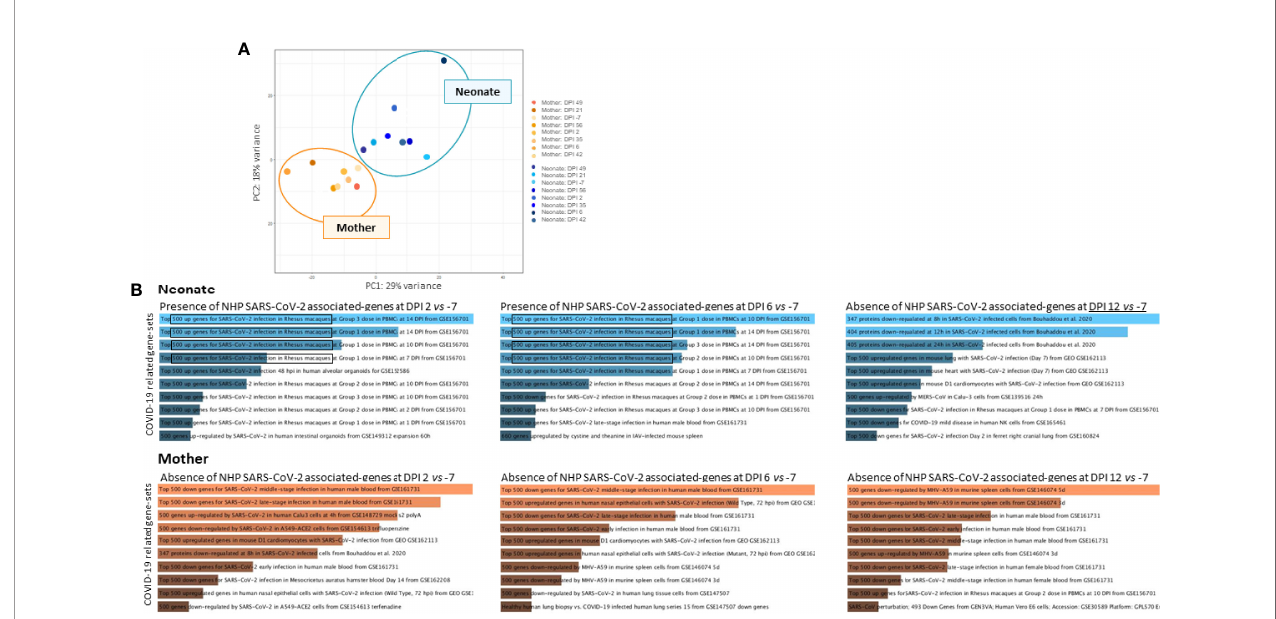
FIGURE 3 | RNA-sequencing analyses of whole blood. RNA-sequencing experiments on longitudinal whole blood samples (DPI − 7, 2, 6, 12, 21, 35, 42, 49, and 56) to detect the presence of COVID-19-associated gene sets. (A) Principal component analysis (PCA) of neonate samples (blue) and mother samples (orange) show no association between individuals where mother and neonate samples are presented. (B) Increased host-responding genes to SARS-CoV-2 infection at DPI 2 and DPI 6 compared with the baseline at DPI − 7 were observed, in the neonate (upper panel in blue) but not in the mother (lower panel in orange). SARS-CoV-2- associated genes decrease at DPI 12 in the